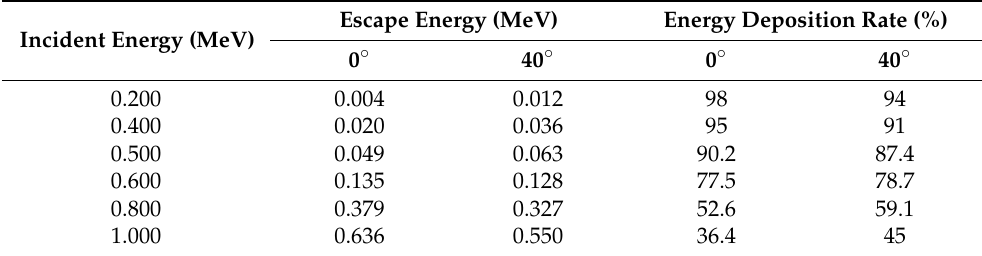
Table 2. Total energy deposition rate in the multilayer structure.